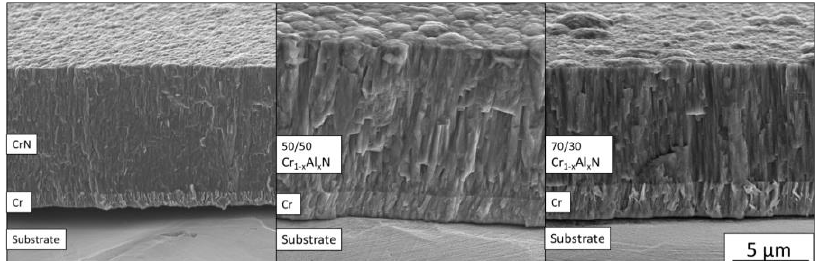
Figure 4. SEM images acquired from the cross-section view of the Cr-Al-N ceramic coatings. All images are in the same scale.